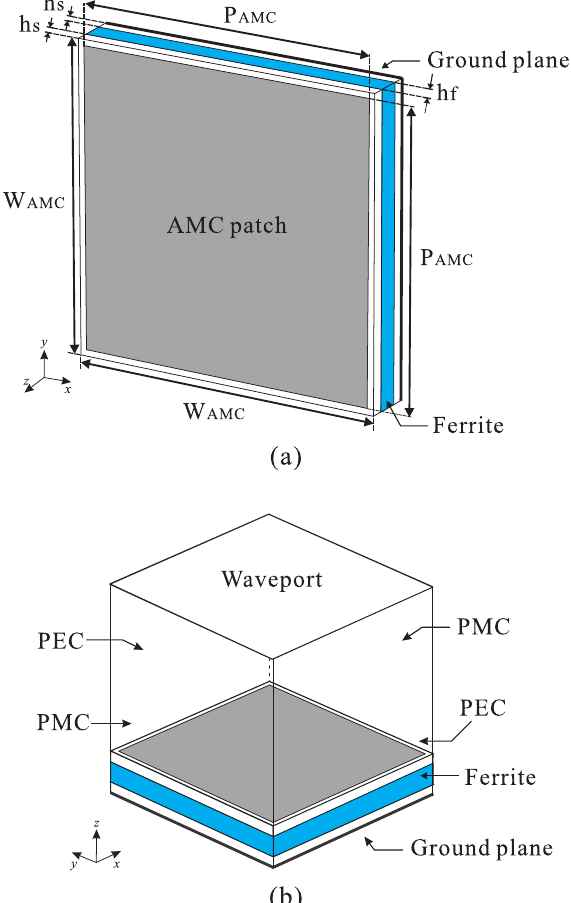
Figure 2. Geometry of the proposed unit cell of the artificial magnetic conductor (AMC): ( a ) perspective-view; ( b ) boundary